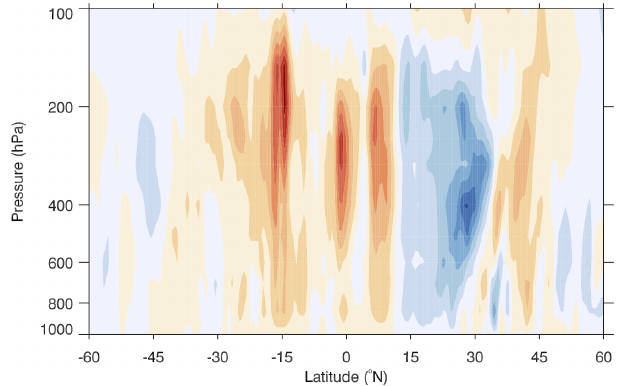
Figure 7. Vertical velocity (ms − 1 ) averaged over the 5 ◦ of longi- tude centred on 140 ◦ E. Positive values indicate